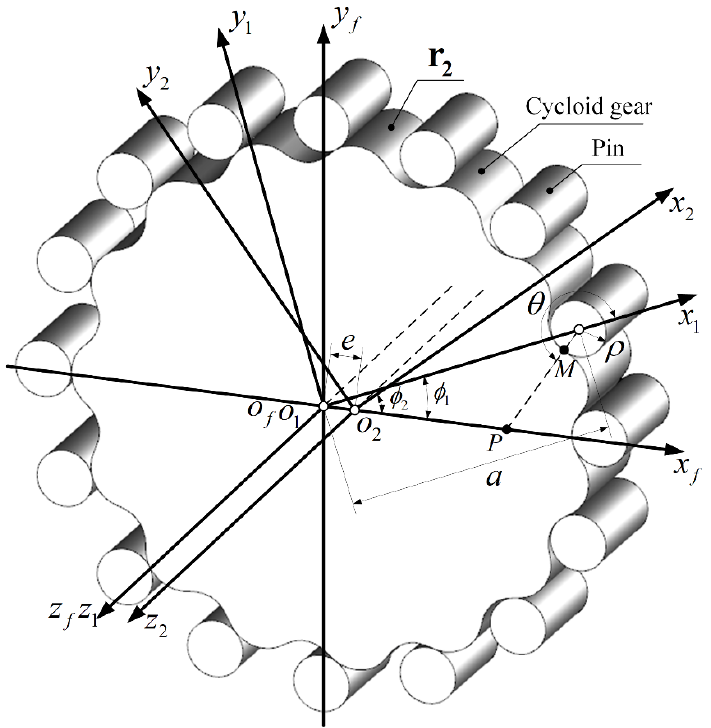
Figure 2. Coordinate systems for the generation of cycloid gear tooth surfaces.